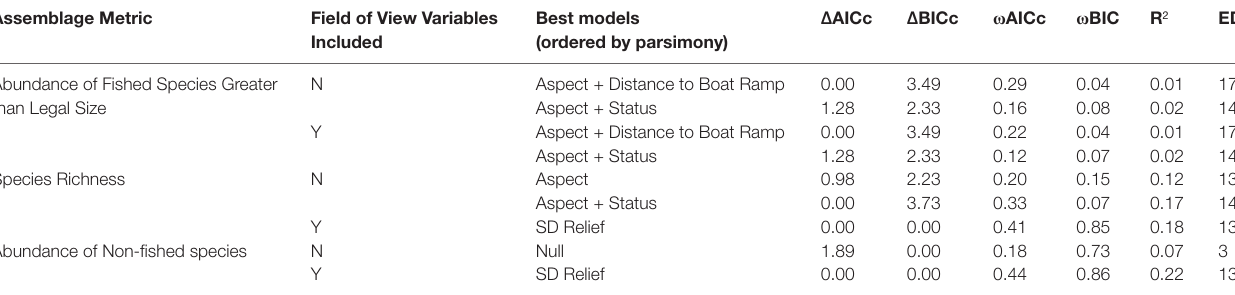
TABLE 2 | Top two models ordered by parsimony for each assemblage metric, with and without field of view variables included. Assemblage Metric